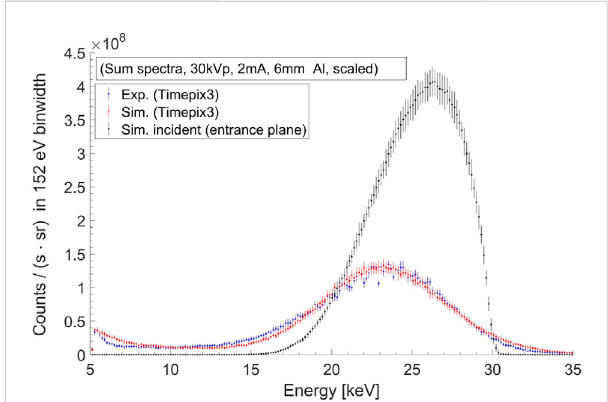
FIGURE 2 Excitation beam sum-spectra in the MoNP case (with 30 kV tube voltage, 2 mA tube current, 6 mm aluminium fi lter)from experimental measurements using Timepix3 detector (blue), detector simulations (red), and the simulated incident sum-spectrum